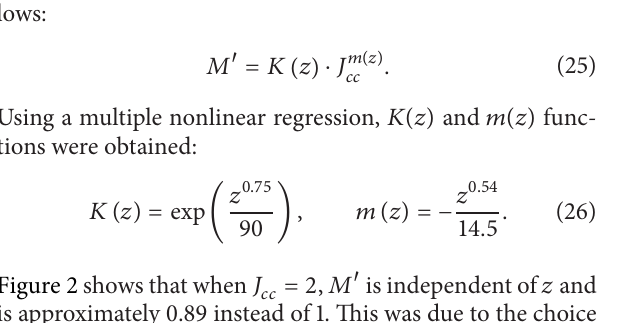
Figure 3: Predicted 𝑓 ℎ /𝑈 values using the mathematical model versus desired Stumbo’s values of 𝑓 ℎ /𝑈